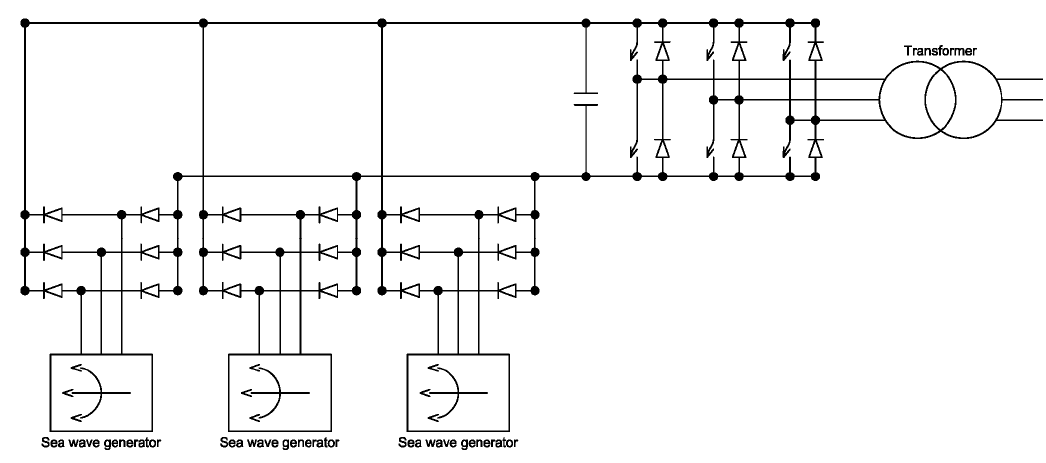
Figure 10. Decentralized approach to the interconnection of a seawave generator to the grid.